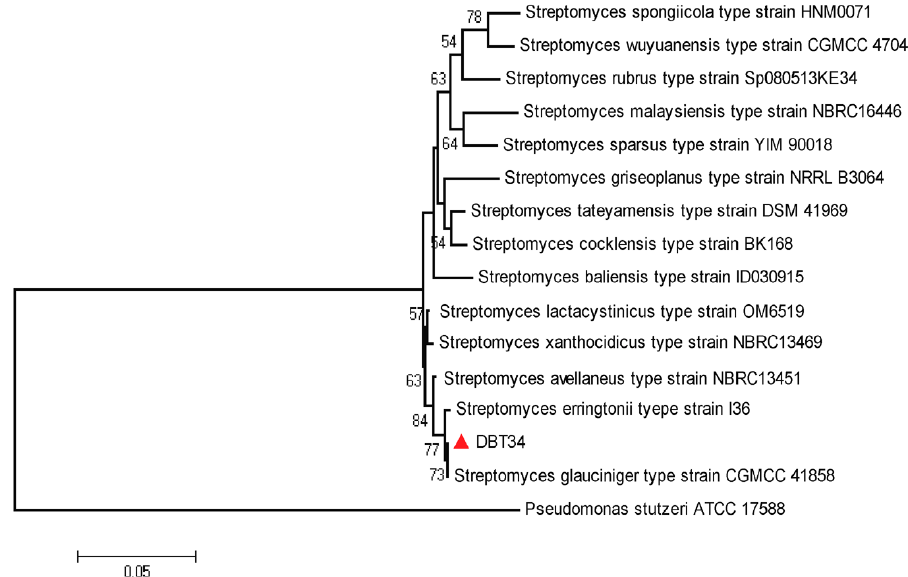
Figure 1. Phylogenetic relationship between Streptomyces sp., strain DBT34 and other strain types retrieved from the EZ-Taxon database, based on partial 16S rRNA gene sequences. The phylogenetic tree was constructed using the neighbor-joining method with the Tamura 3-parameter model with 1000 bootstrap replicates. Value mentioned at nodes is bootstrap values and our strain is mentioned against red triangle.